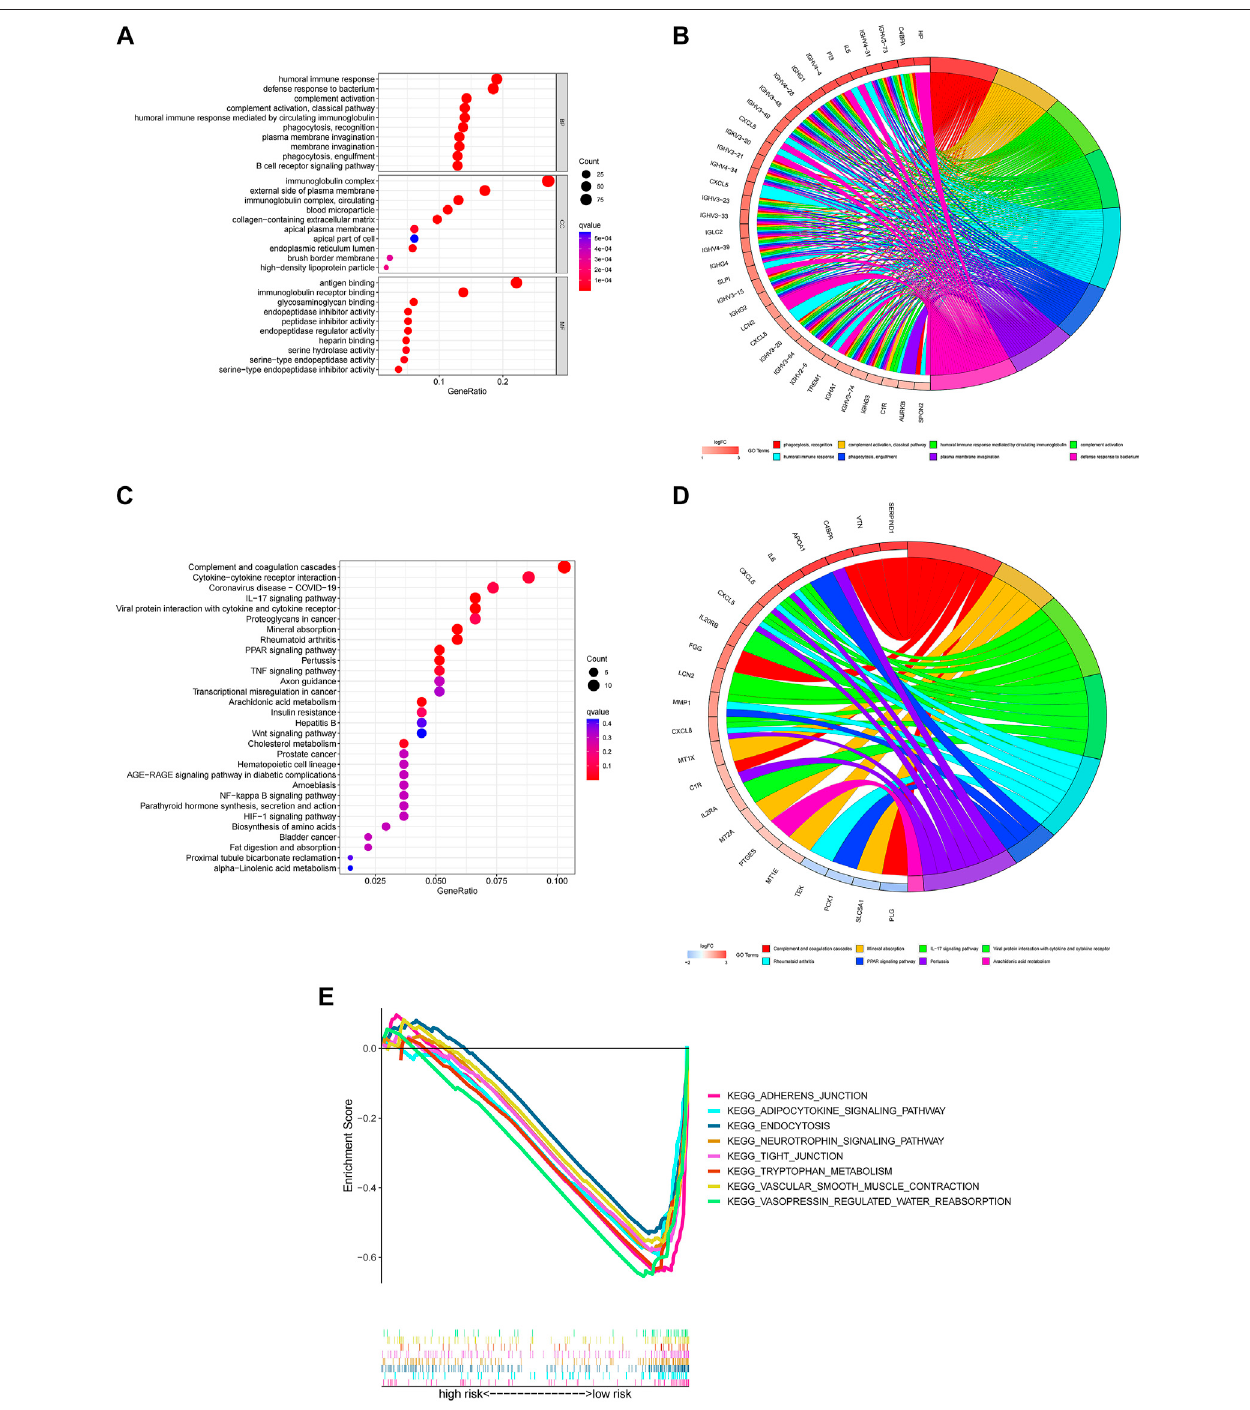
FIGURE 6 | Functional enrichment for differentially expressed m7G genes between two groups (A) The top 30 signi fi cant terms of GO functional enrichment. BP biological process, CC cellular component, MF molecular function. (B) The circle diagram enriched in the GO analysis. (C) The top 30 signi fi cant terms of KEGG functional enrichment. (D) The circle diagram enriched in the KEGG analysis. (E) GSEA of the top 8 pathways signi fi cantly enriched in the low-risk group.